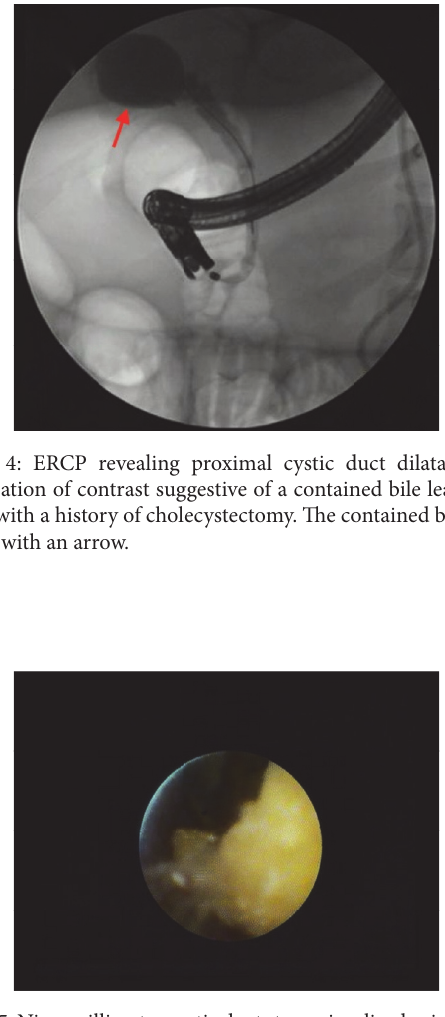
Figure 5: Nine-millimeter cystic duct stone visualized using peroral